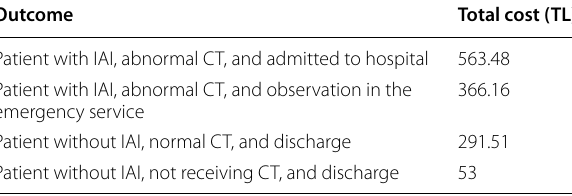
IAI intraabdominal injury, CT computed tomography